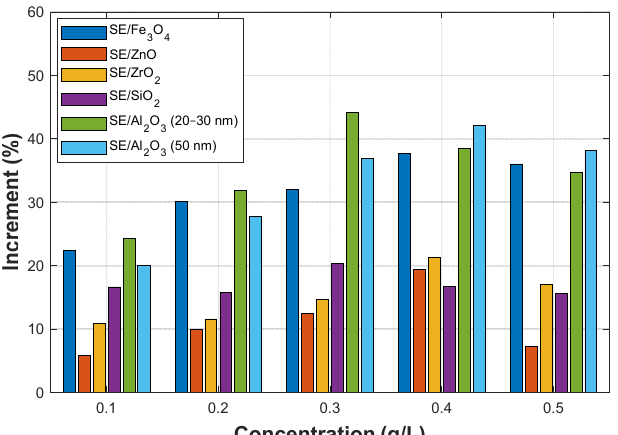
Figure 5. Mean breakdown voltages of synthetic ester and synthetic ester-based nanofluid at differ- ent concentrations of nanoparticles: ( a ) Fe 3 O 4 (20 nm), ( b ) ZnO (25 nm), ( c ) ZrO 2 (20–30 nm), ( d ) SiO 2